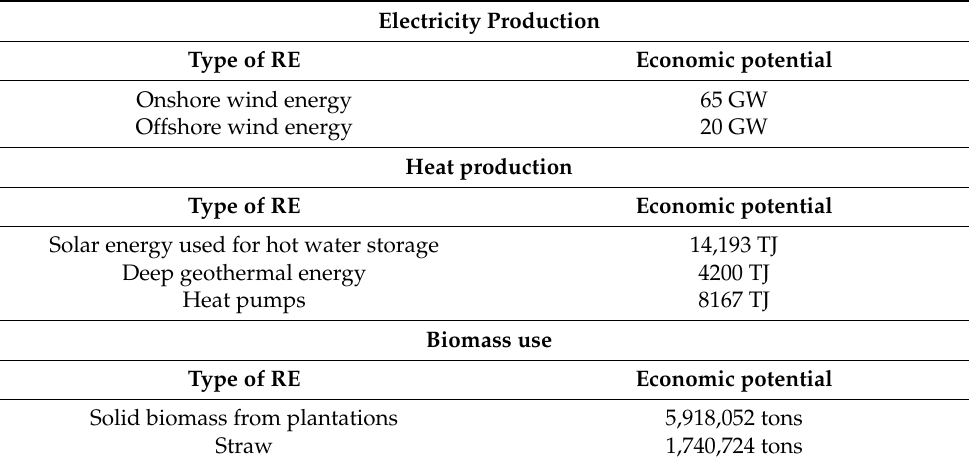
Table 1. Economic potential of RE sources in Poland